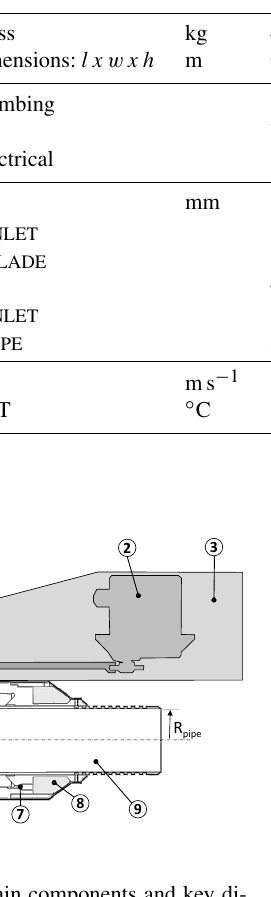
Figure 1. Probe schematic showing main components and key di- mensions (see Table